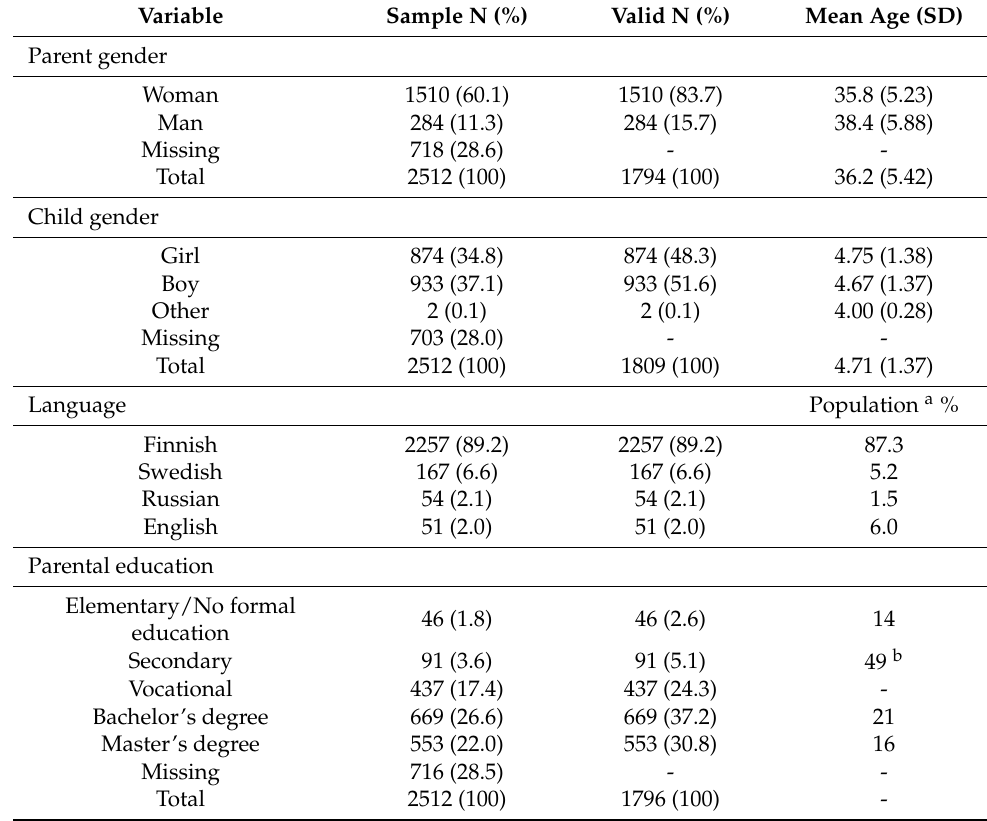
Table 1. Descriptive characteristics of the participants ( n =